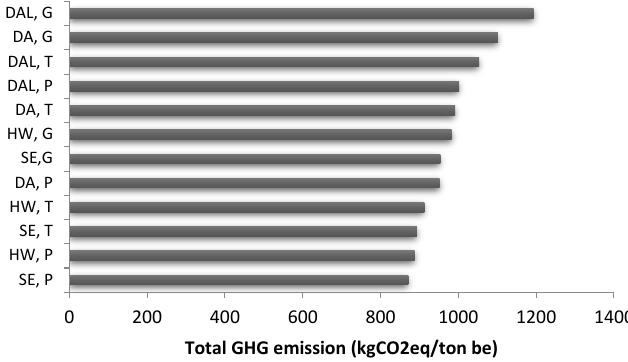
Figure 6. Total GHG emission for 1 ton of bioethanol produced by using different wastes.